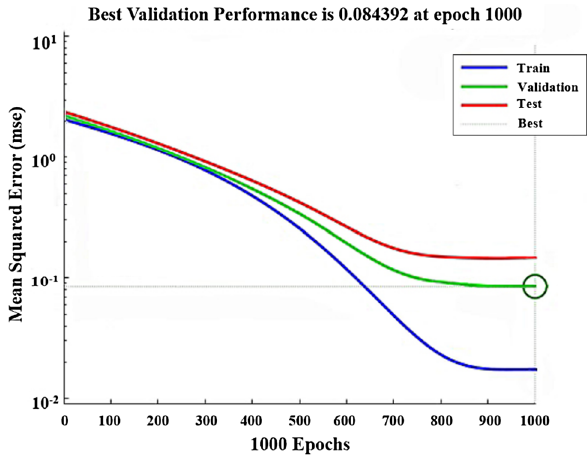
Fig. 11 Performance of the single-point stagnant water prediction model in training and